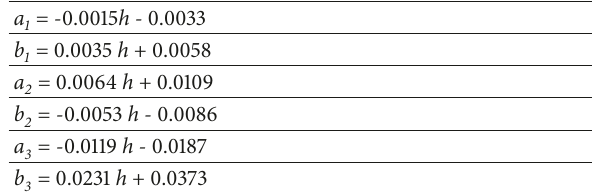
Table 3: Relationship between filling height and a